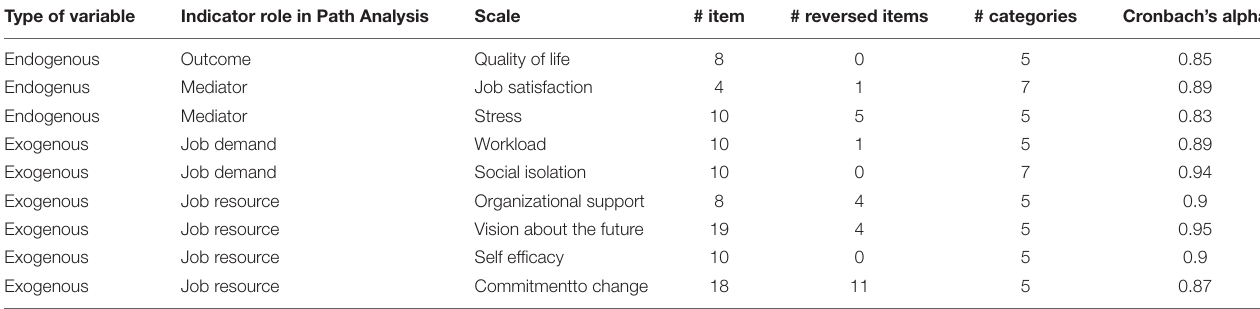
TABLE 1 | Scale information ( n =